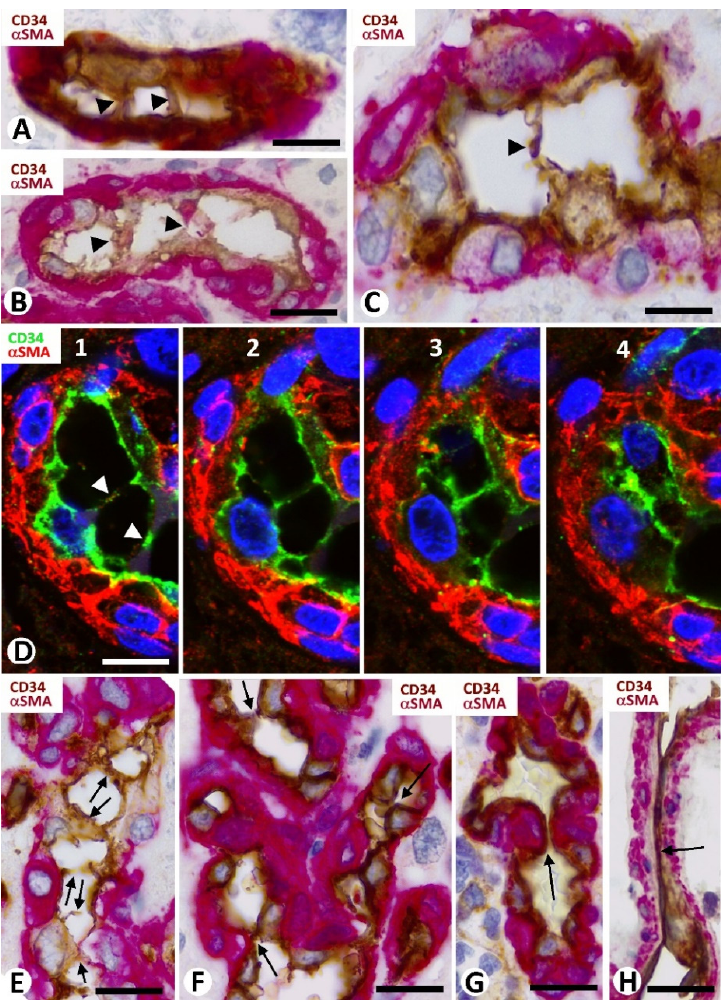
Figure 6. Pillars and EC contacts in bizarre vessels of GBM. ( A – E ) EC bridges (arrowheads and arrows) are observed between opposite vessel walls. Note in ( D1–4 ) the appearance and disappearance of pillars in a series of individual views in confocal microscopy. Two or more pillars can be observed in the same vessel ( A , B , E ). ( F – H ) Apical (F, arrows)) and planar ( G , H , arrows) EC contacts from opposite vessel walls. Observe that the planar contacts can be with ( G ) or without ( H ) prominence of pericytes (red). ( A – C , E – H ) Double immunochemistry for CD34 (brown) and α SMA (red). Hema- toxylin counterstain. ( D1–4 ): Double immunofluorescence for CD34 (green) and α SMA (red). DAPI counterstain. Bar: ( A , B , E – G ) 20 µ m, ( C , D ) 15 µ m, and ( H ) 40 µ